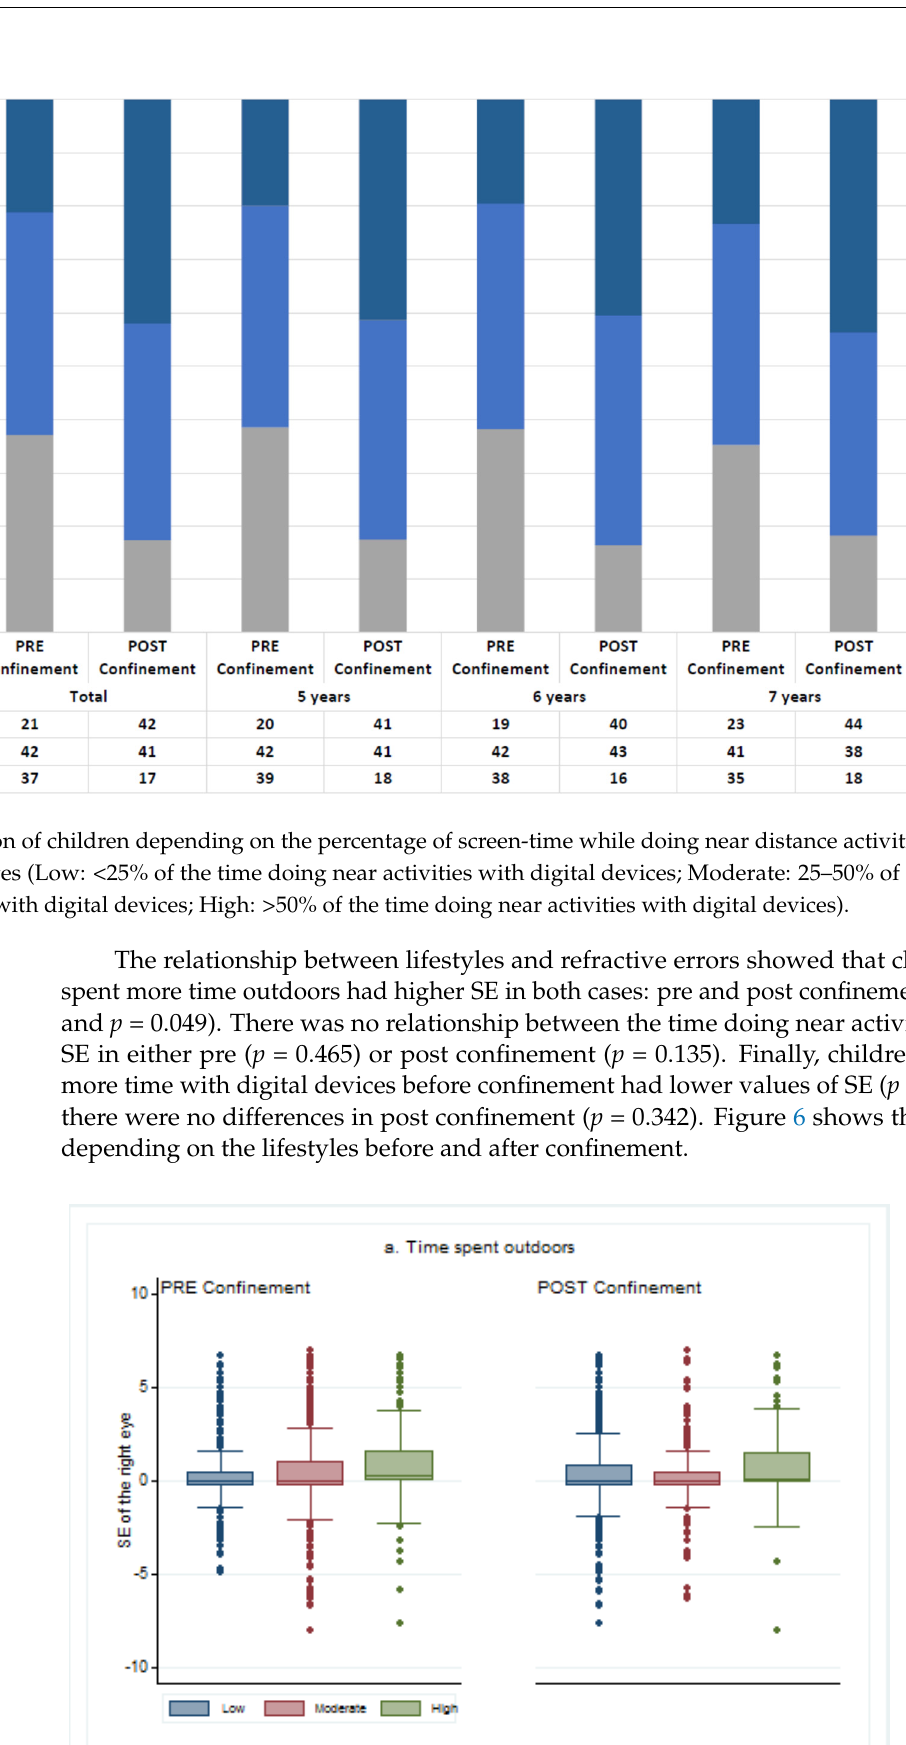
Figure 4. Classification of children depending on the time they spent doing near distance activities in all the sample and by ages (Low: <2 h a day; Moderate: 2–3 h a day; High: >3 h a day).